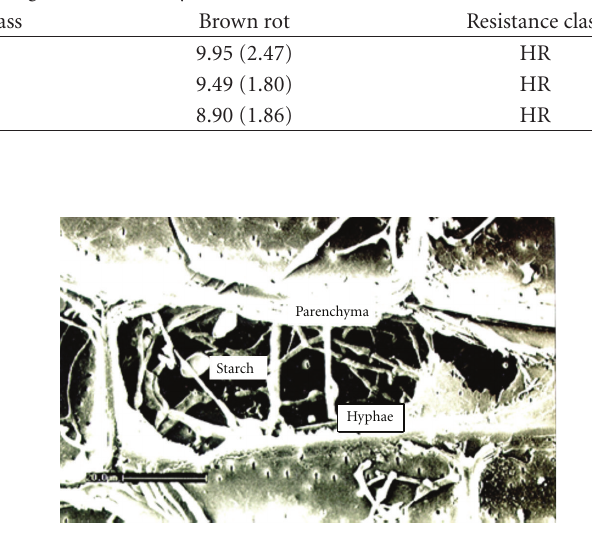
Figure 3: Starch granules utilized by white rot hyphae in Parenchyma cell (longitudinal, 1000x).